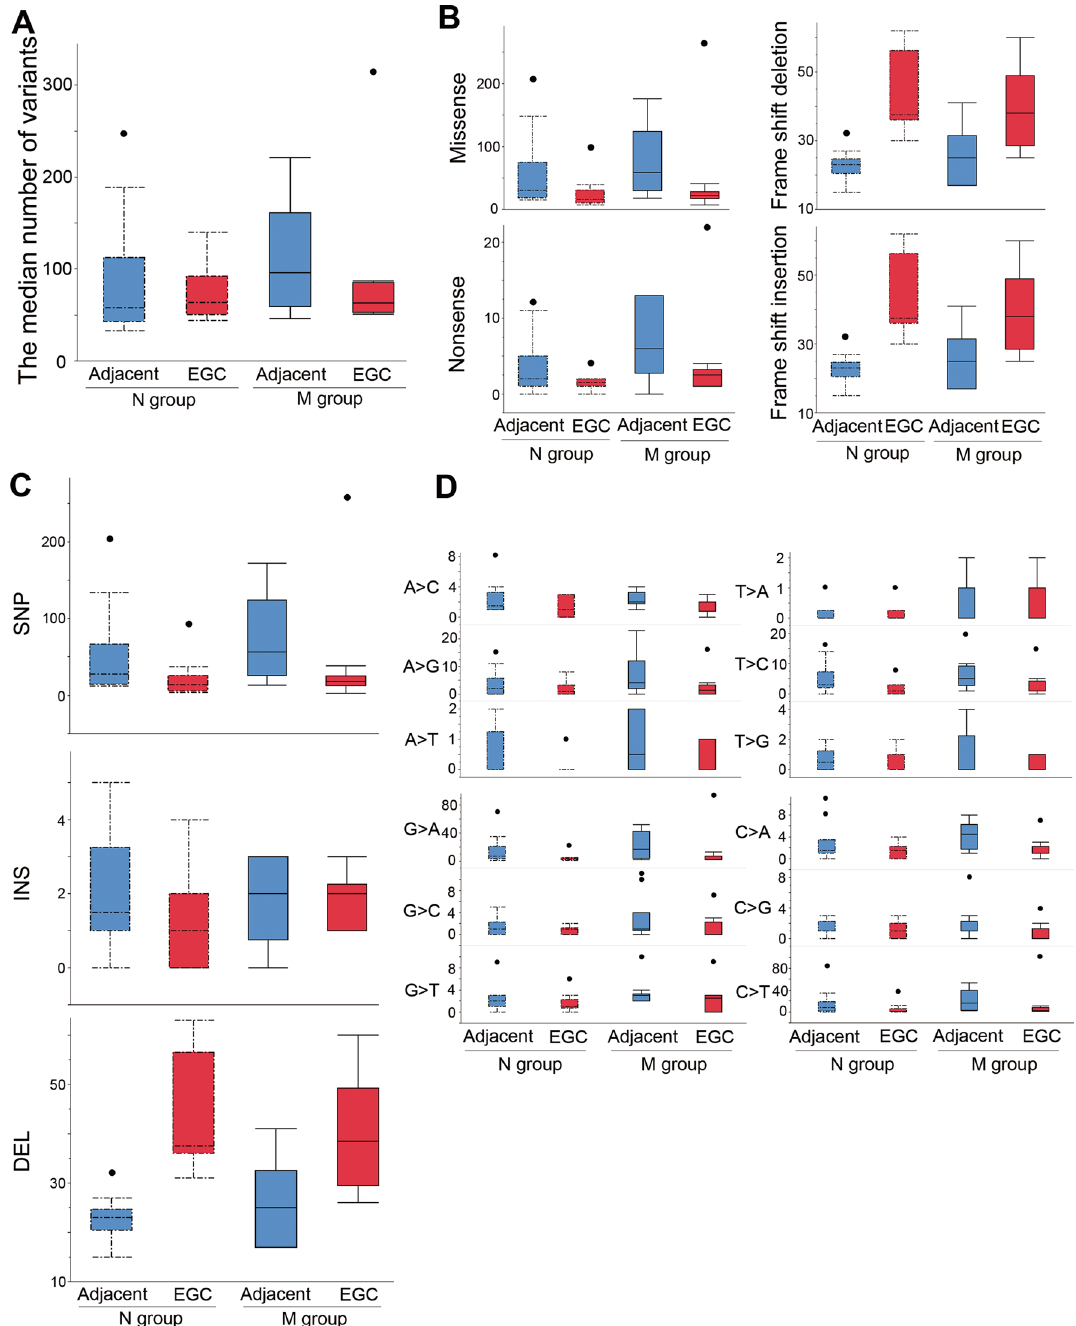
Figure 3. Comparison of somatic variants between the N and M groups. The median numbers of somatic variants were 58.0 (IQR, 42.7–112.5) in the adjacent non-cancerous mucosa of the N group, 63.5 (IQR, 50.2–92.5) in the initial EGC of the N group, 96.0 (IQR, 59.5–161.2) in the adjacent non-cancerous mucosa of the M group, and 63.0 (IQR, 53.2–85.5) in the initial EGC of the M group ( p = 0.36, A ). The classification ( B ) or type ( C ) of variants and SNP classes ( D ) were not significantly different between the groups. Box plot: the bottom and top of each box represent the 25th and 75th percentiles, respectively, and the band in the box is the median. Whiskers: the lowest datum is within the minimum, and the highest datum is still within the 1.5 IQR of the upper quartile. Values of outliers are drawn as dots. We used the Kruskal–Wallis test, with post hoc Steel– Dwass test, to evaluate the statistical differences between groups. Actual values are provided in Suppl. Table 3. SNP single nucleotide polymorphism, INS insertion, DEL